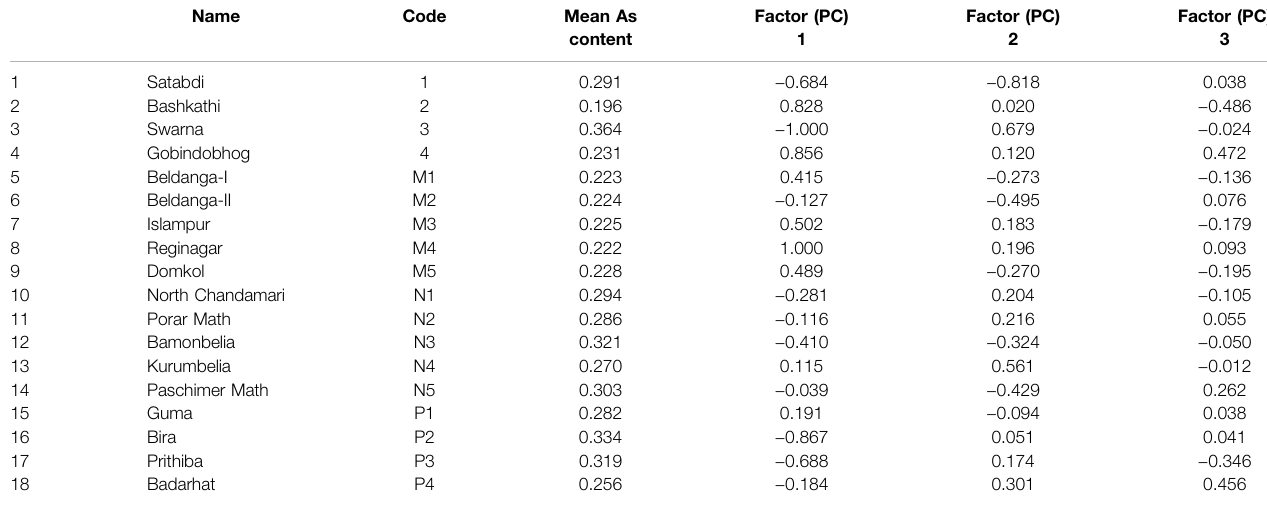
TABLE 4 | Eigenvectors of factors in additive main effects and multiplicative interaction biplot analysis of As content in grains for 4 varieties grown in 14